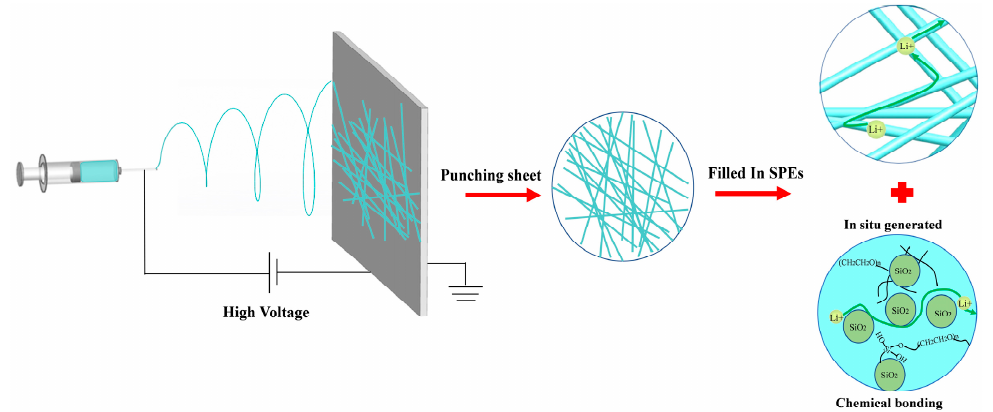
Figure 1. Schematic diagram for preparation of in-situ-generated electrospun CPE, and the interaction mechanism of in-situ-generated SiO 2 on PEO chains.